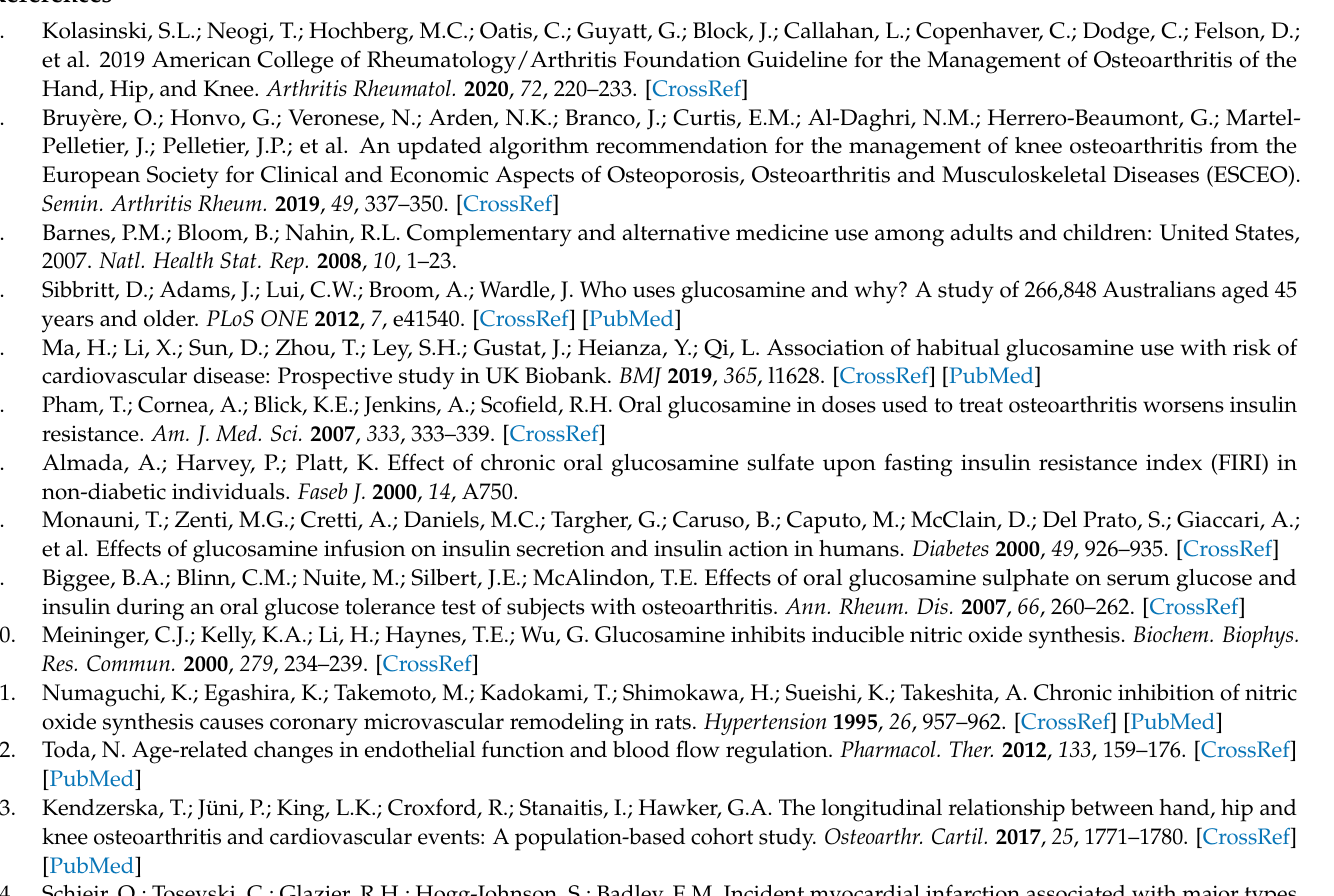
Figure A1. Flow chart of the study. UEBMI, urban employee basic medical insurance.